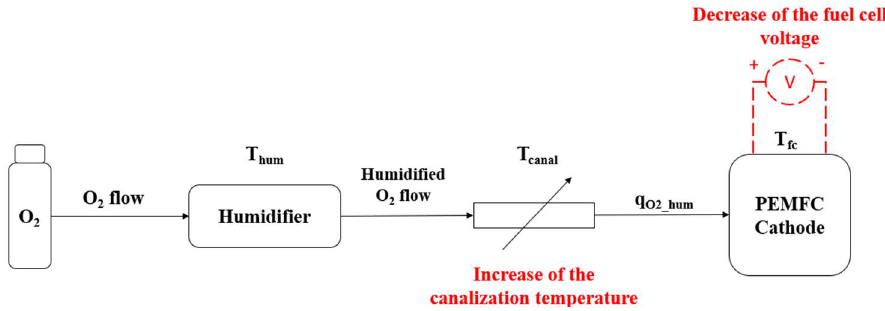
Figure 16. Fuel cell cathode line gas feeding from [13] for membrane drying out.